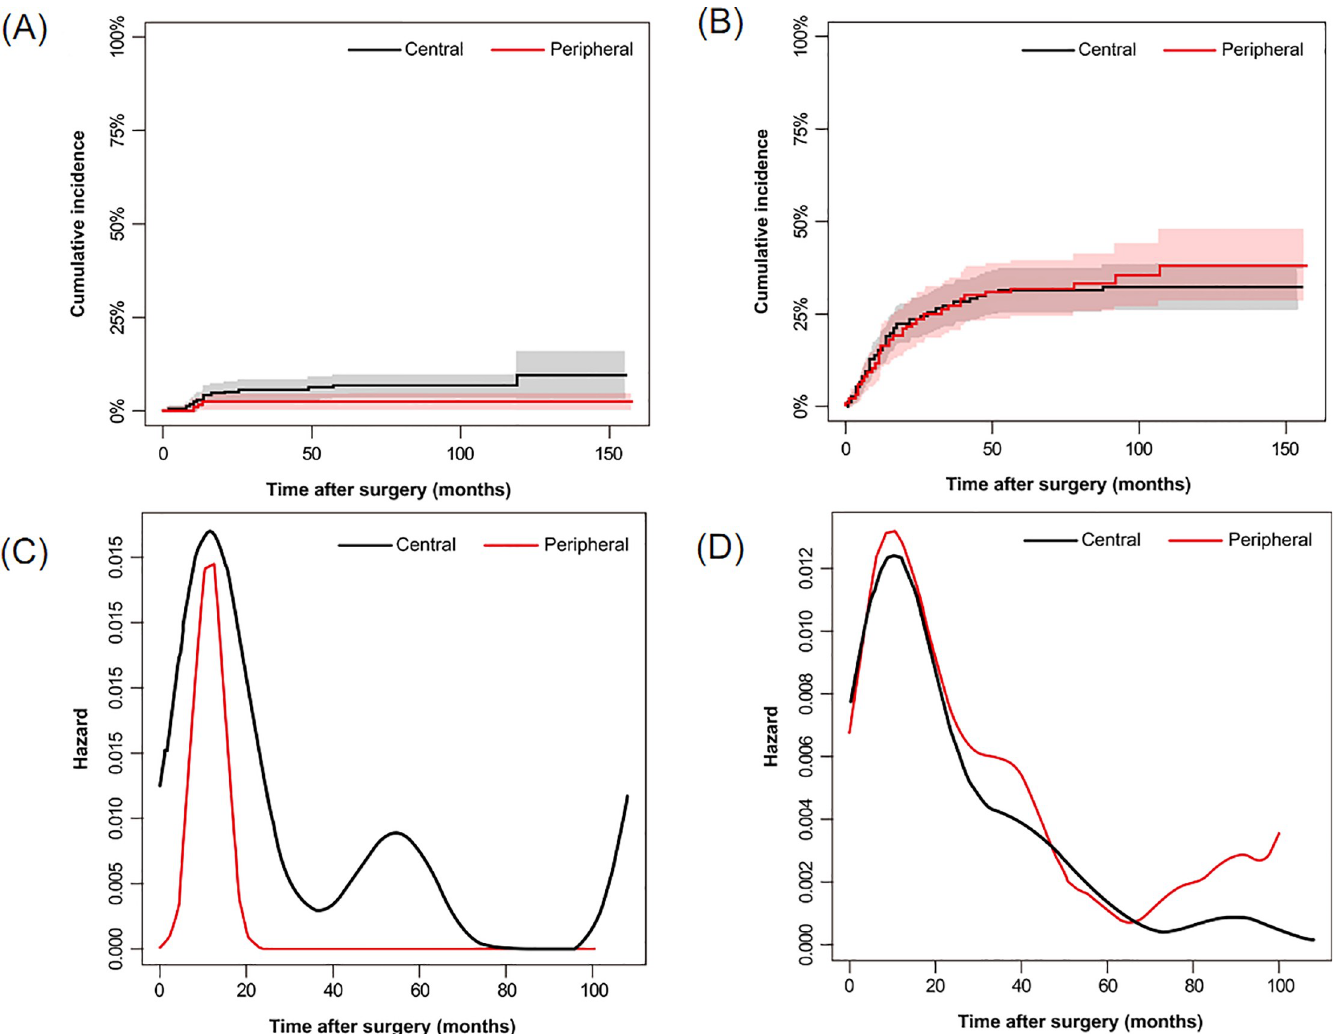
Fig 5. Comparison of the Cumulative Incidence Rate of Recurrence and Metastasis (A and B) and Recurrence/Metastasis Hazard Rate (C and D) according to Tumor Location. The rate of local recurrence is shown in A and C, and the rate of distant metastasis is shown in B and D. Central tumors had higher peaks on the local recurrence curve, while peripheral tumors were at higher risk of developing distant metastasis 60 months after surgery. Gray and pink areas represent the 95% confidence intervals of the black and red plots in A and